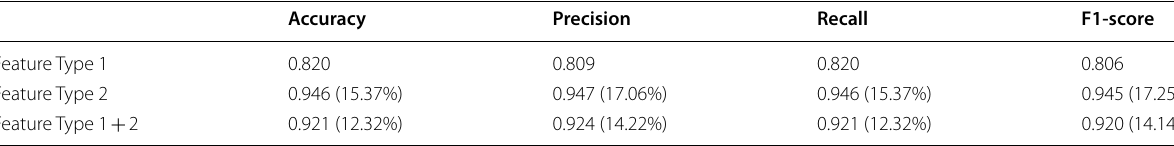
Table 5 Comparison of classification results between different feature